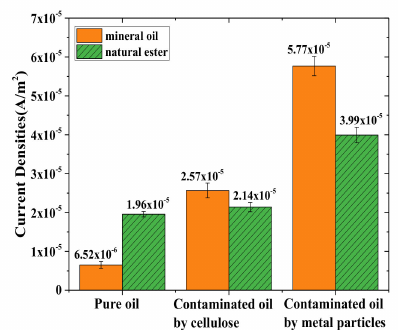
Figure 8. Comparison of saturated current in insulation oil containing fiber and copper